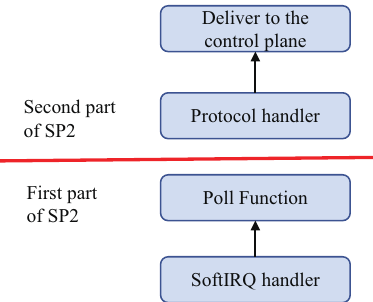
Figure 3. Separate packet processing (SP2) divides network processing routines into two stages, a minimized poll function (first part) and a protocol handler (second part).